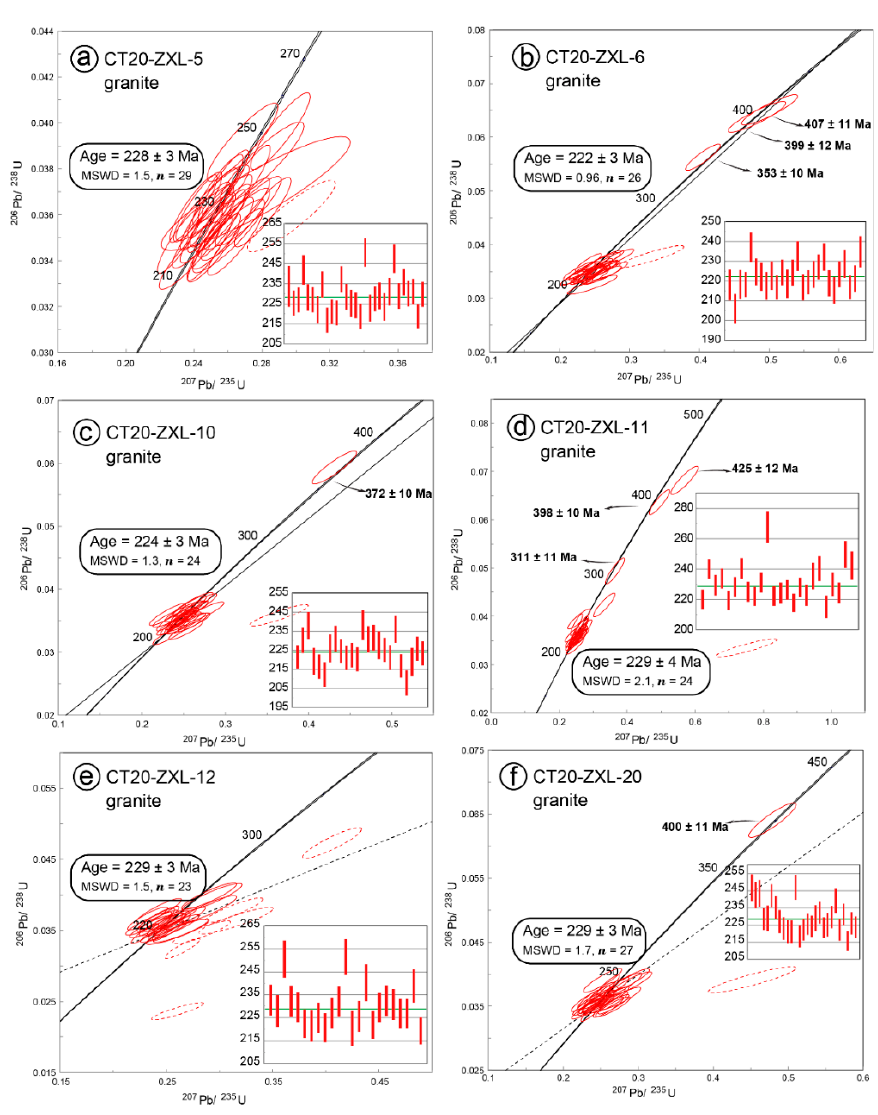
Figure 12. U-Pb Concordia diagrams for samples from Indosinian intrusions that have widespread development in the core of the Taoxi dome. ( a ) Concordia diagram and weighted average age dia- gram of sample CT20-ZXL-5. ( b ) Concordia diagram and weighted average age diagram of sample